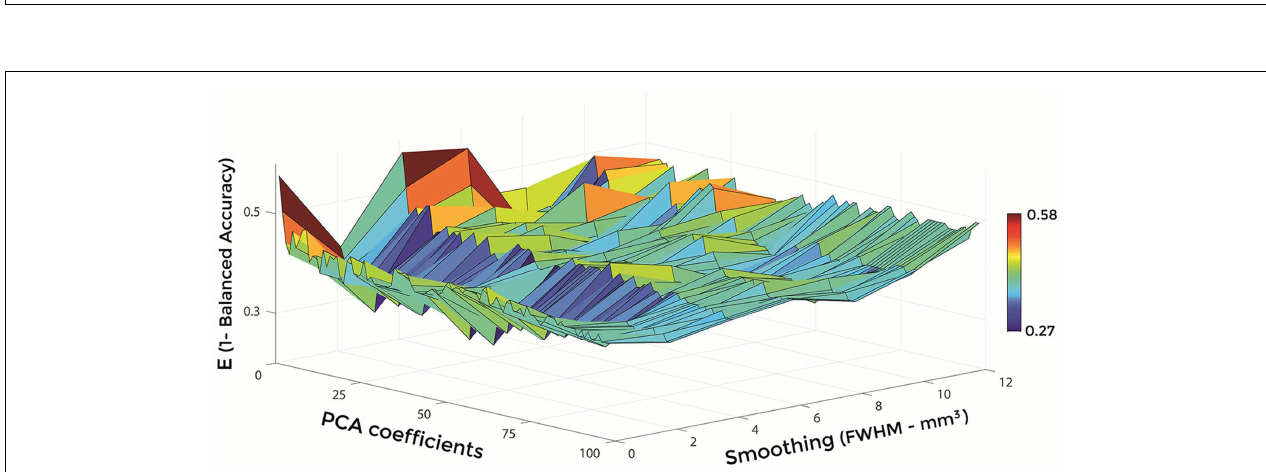
FIGURE 8 | E (1 – Balanced Accuracy) as a function of smoothing (FWHM – mm 3 ) and number of PCA coefficients for the comparison between MCIc and MCInc when using GM.